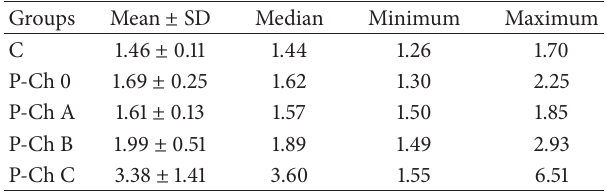
Table4:IL-1 𝛼 concentration(pg/mL)intheserumofalcoholicsand healthy controls.